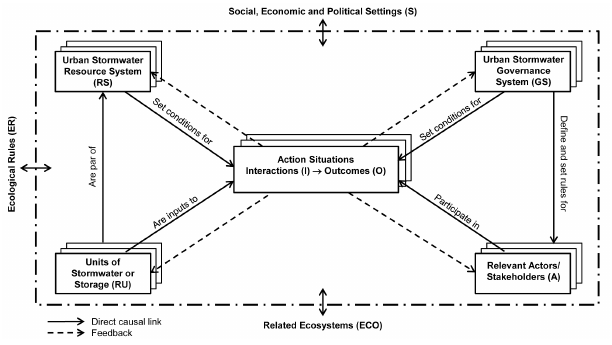
Fig. 2 . First tiers of social-ecological system framework for an urban stormwater social-ecological system (adapted from Ostrom [2007] and Epstein et al.